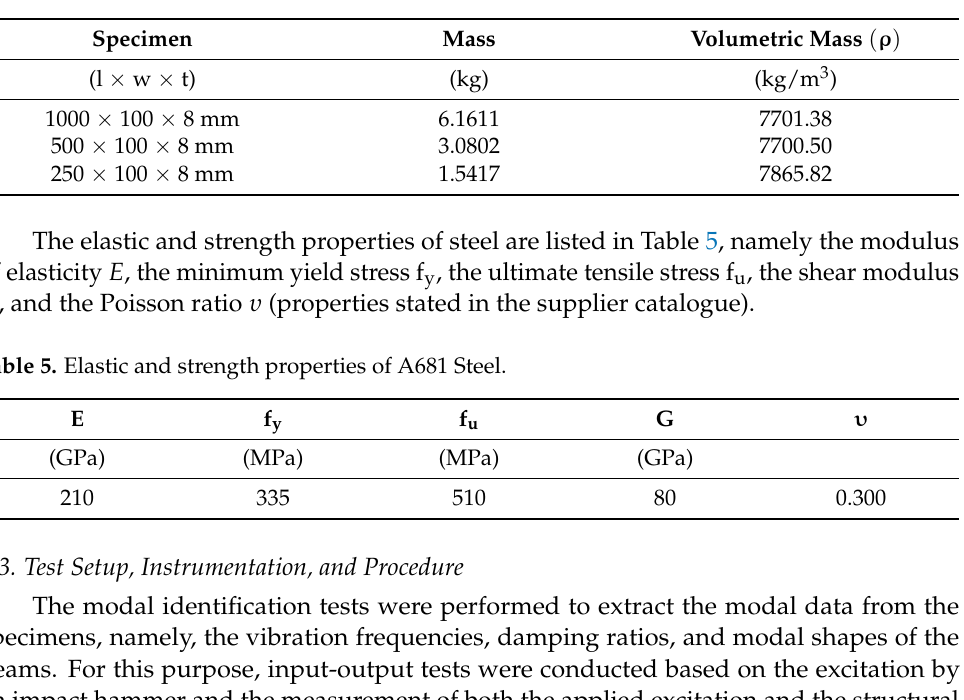
Figure 5. Geometry of steel specimens (dimensions in mm). Table 4. Mass and density of steel specimens.